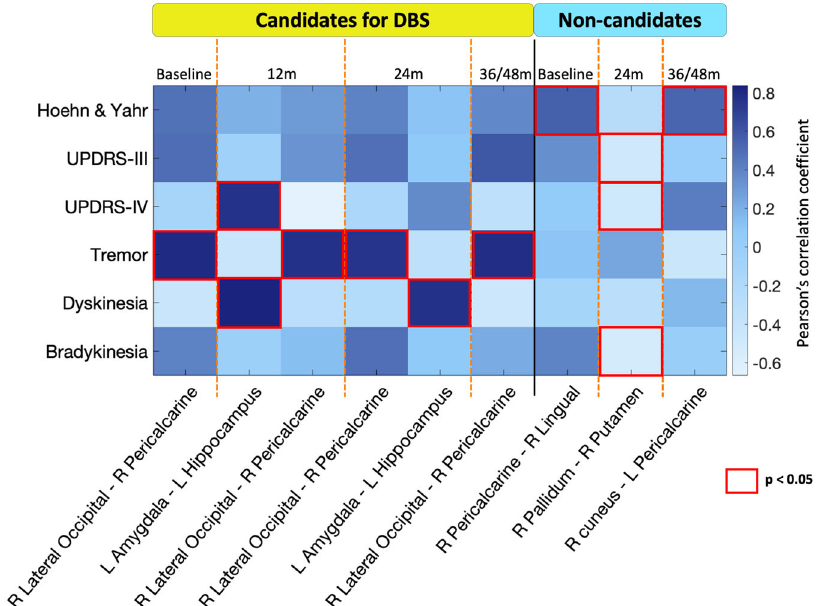
Fig. 4 Clinical-MRI correlations between functional network properties and clinical data in each Parkinson ’ s disease group. Each column shows functional brain proprieties and each row clinical data at baseline and at each time point. Color scale represents Pearson ’ s correlation coef fi cient. Red squares indicate statistical signi fi cance at a threshold of p < 0.05. For further details see Supplementary Table 4. Candidates for DBS patients eligible for DBS, L left, m months, Non-candidates patients not eligible for DBS, R right, UPDRS Uni fi ed Parkinson ’ s disease rating